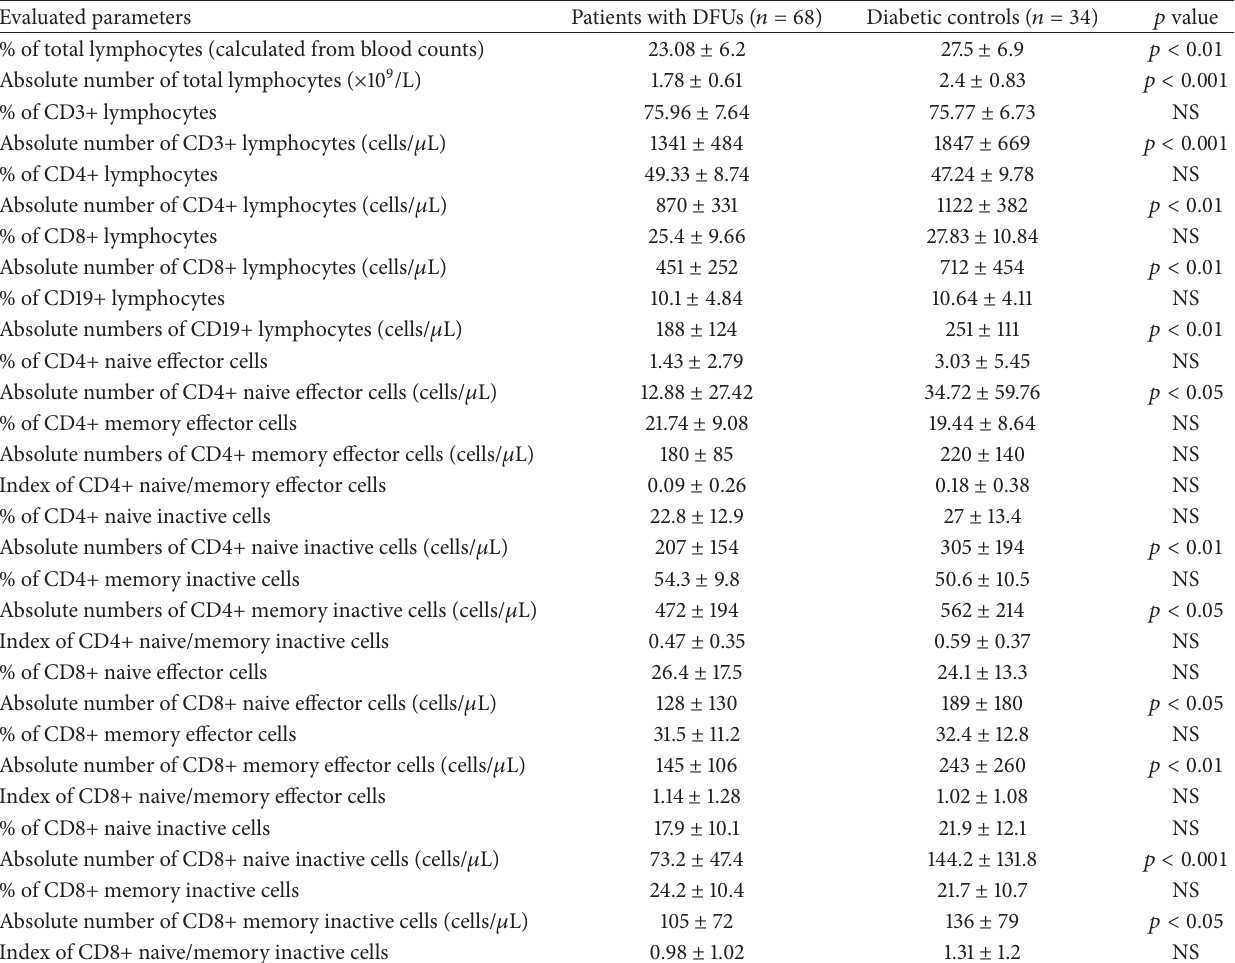
Table 3: The differences in selected parameters of cell-mediated immunity between the study groups. Evaluated parameters